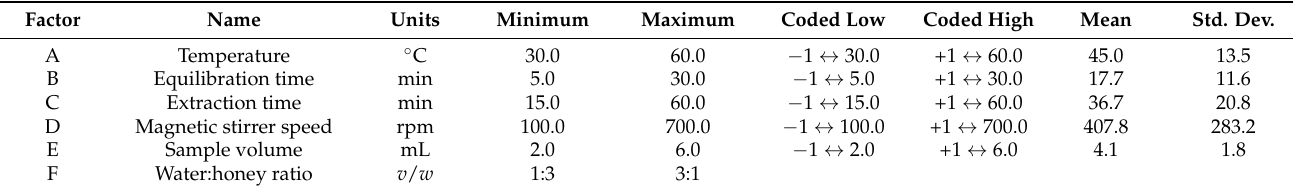
Table 6. Independent experimental